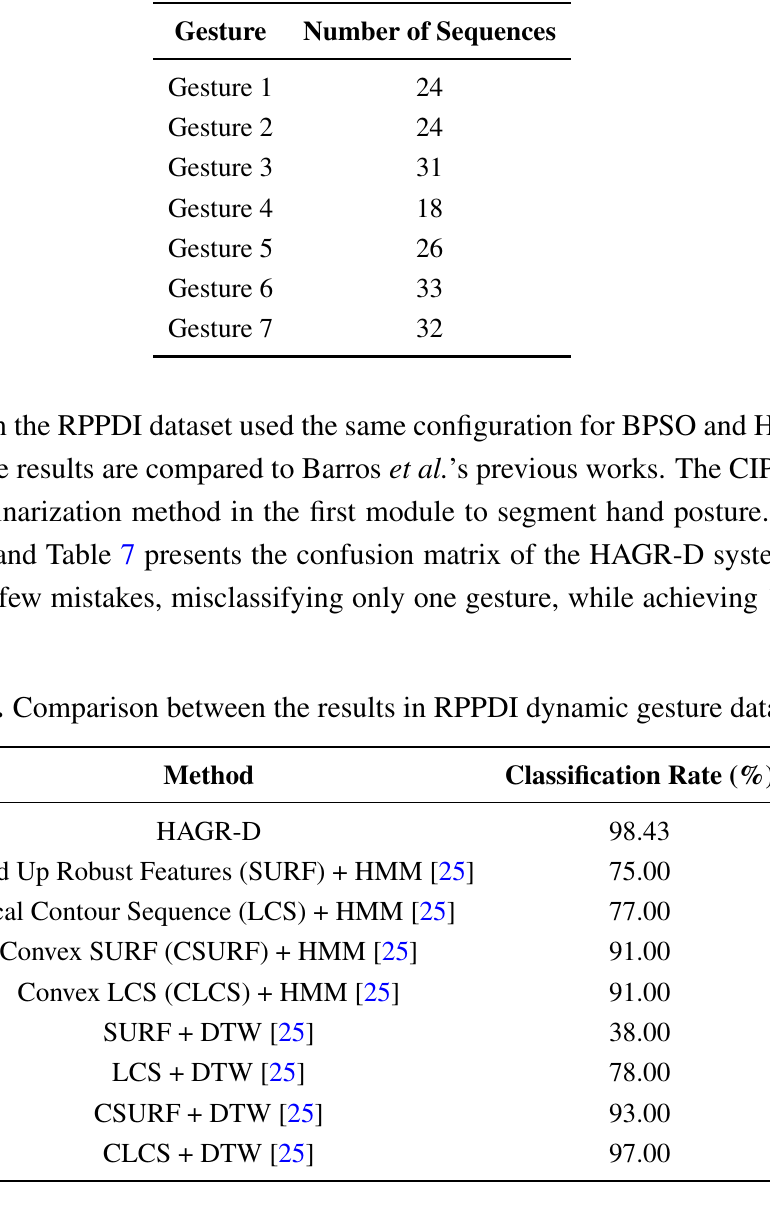
Figure 8. Example for each of the gestures performed on the RPPDI dynamic gesture dataset. Table 5. Number of sequences captured by each gesture in the RPPDI dynamic dataset.